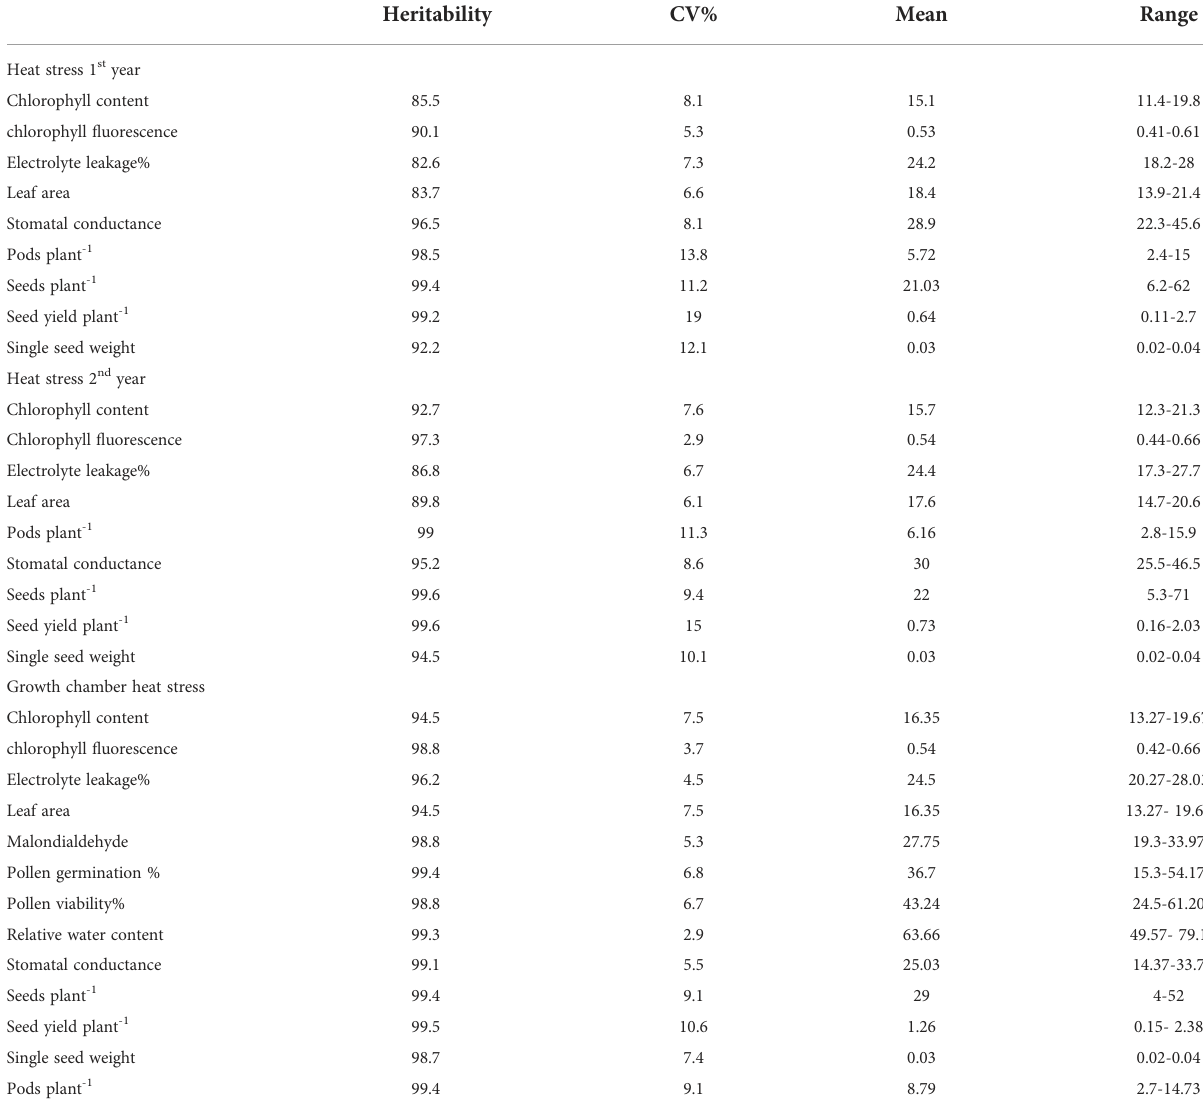
TABLE 1 General statistics of various traits in urdbean genotypes under heat stress